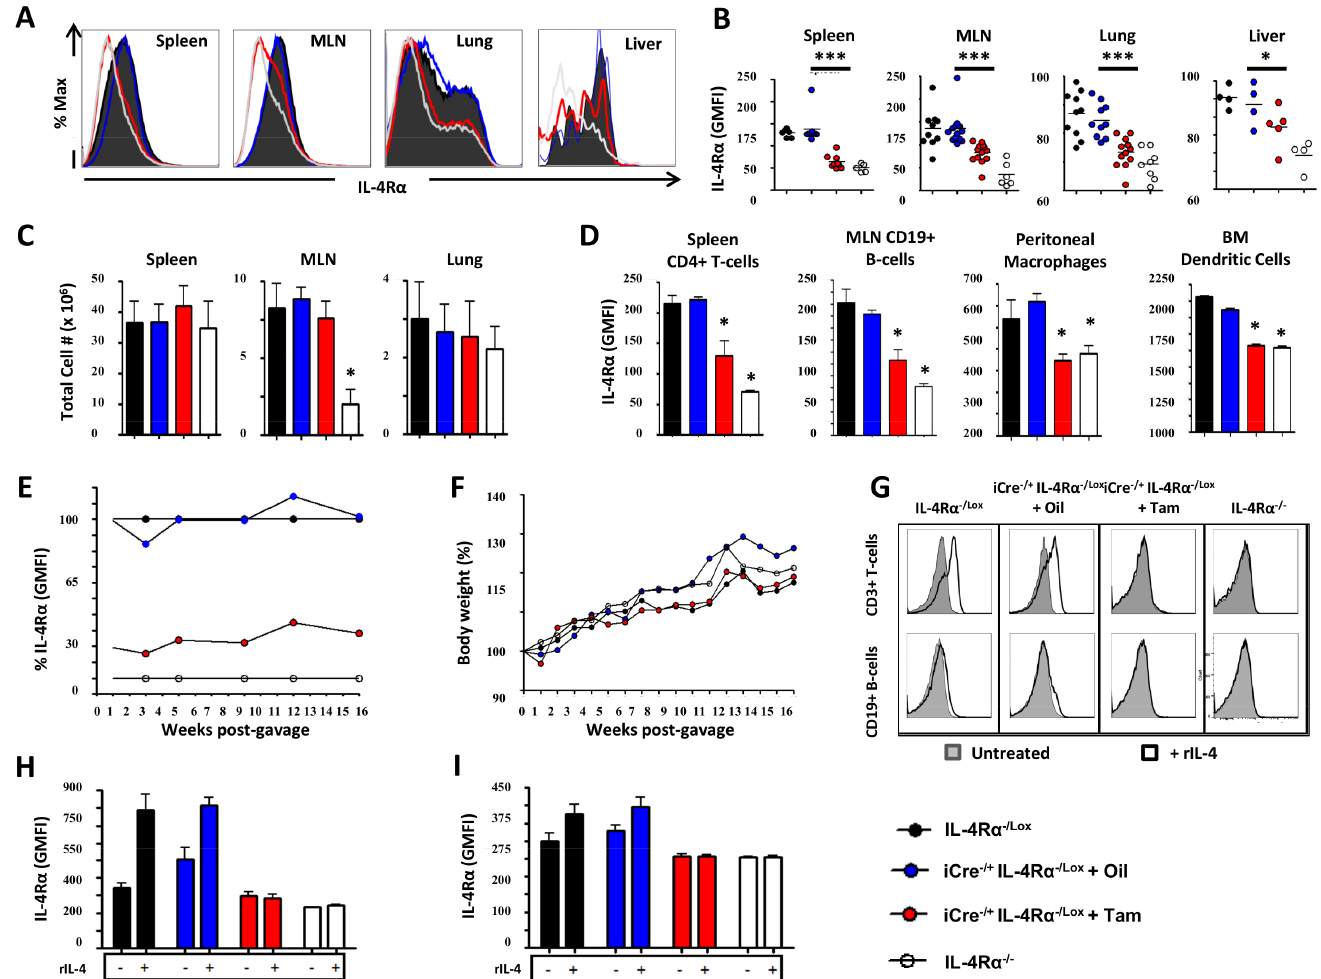
Fig 2. Phenotypic and functional characterization of the RosaCre -/+ IL-4R α -/lox deletable mouse model. A. IL-4R α GMFI of total cellsfrom several organs5 daysfollowingTamoxifen administration summarized in B. C. Total cellnumbersinseveralorgans. D. IL-4R α GMFI of majorimmunecellstaken from severalorgans. E. Kineticsof IL-4R α GMFI changeovertime followingTamoxifen treatmentof RosaCre -/+ IL-4R α -/lox mice.A relativeIL-4R α expression of 100%wasassignedto IL-4R α -/lox mice anda relativeexpressionof 0% was assignedto IL-4R α -/- mice.Do note the similarityin IL-4R α expressionlevels betweenIL-4R α -/lox andoil-treatedRosaCre -/+ IL-4R α -/lox controlmice. F. Long-termeffect of Tamoxifengavageonthe bodyweightof RosaCre -/+ IL-4R α -/lox mice. G. Upregulationof surfaceexpressionof IL-4R α by spleenlymphoidcellsstimulatedwith rIL-4. Cellswerecollected48 hoursfollowingincubation with rIL-4andIL-4R α meansurfaceexpressiononCD3 + T ( H )andCD19 + B cells( I )was determined andplotted. Eachexperimentwas conductedat leasttwice with 3–6mice per group.Dataareexpressedas mean ± SD; NS = p > 0.05; * = p < 0.05; ** = p < 0.01; *** =, p < 0.001; **** = p < 0.0001.